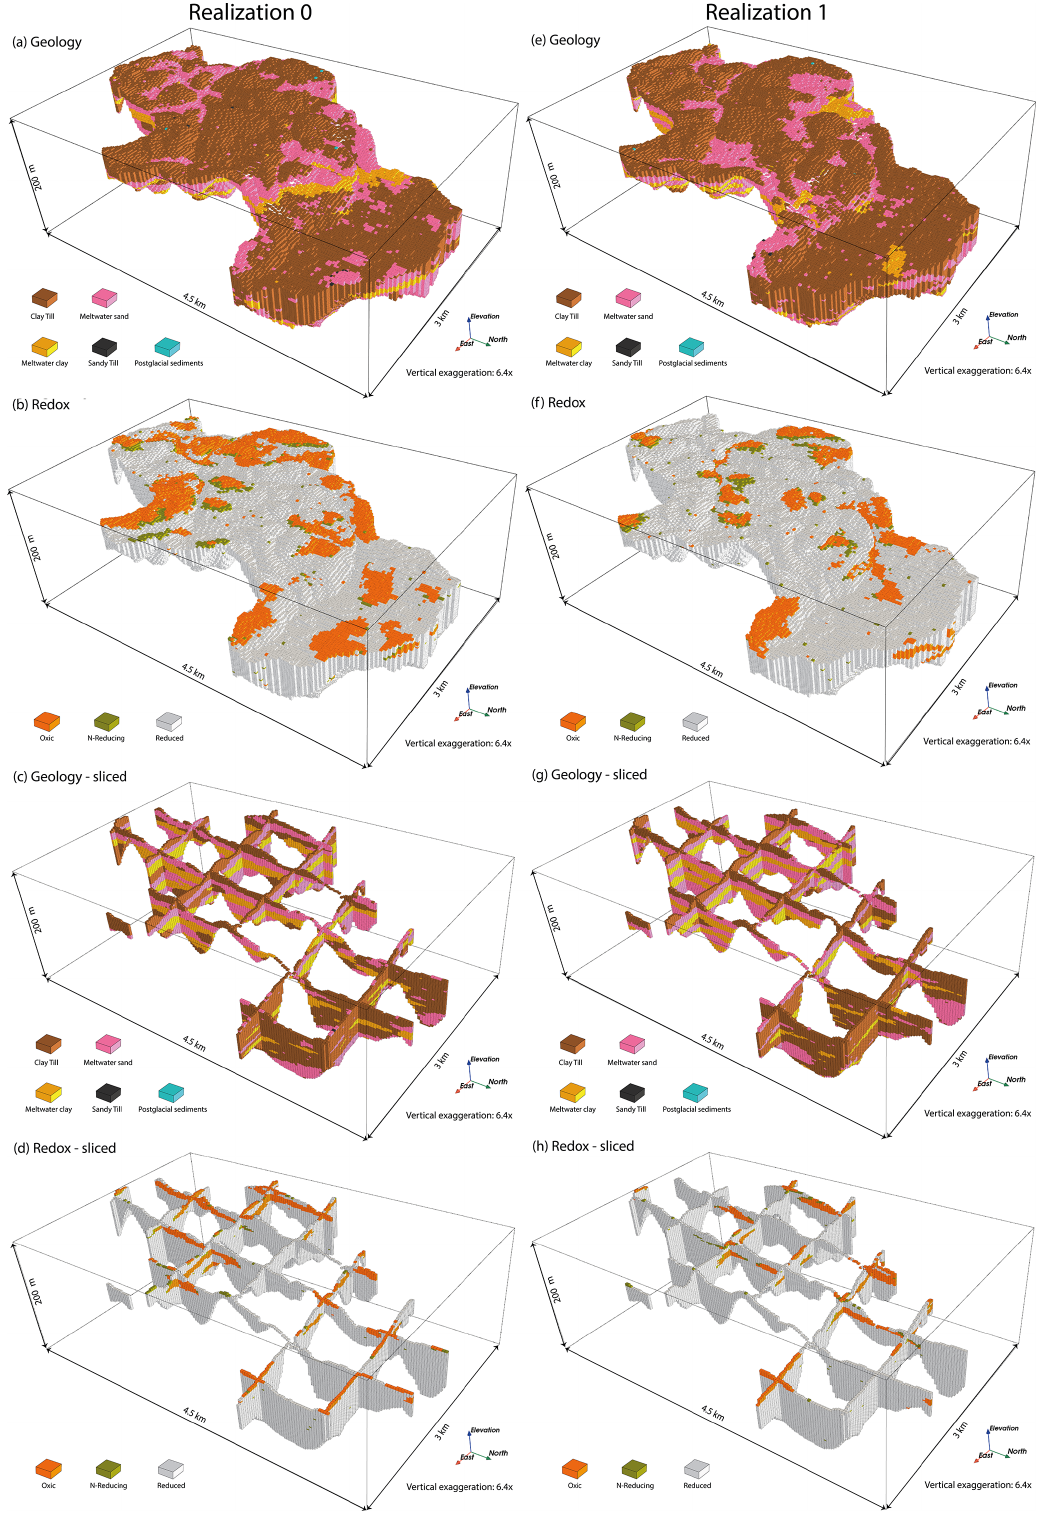
Figure 11. Two unconditional realizations from the prior model. (a, b) One realization of jointly simulated geology and redox. (c, d) The same realization sliced in the x and y directions. (e–h) Same figure configuration as in (a–d) but for a different realization.